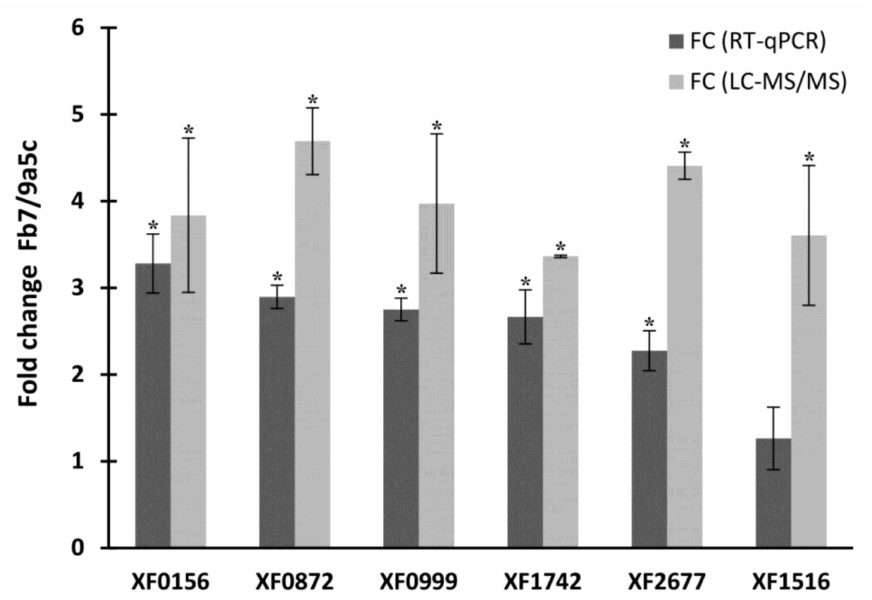
Figure 5. Expression ratios of selected genes comparing X. fastidiosa strains Fb7 and 9a5c, obtained by transcript (RT-qPCR) and protein abundance (LC-MS / MS). Results are expressed as mean ± SD and considered significant (*) if p < 0.001, Dunnett’s multiple comparison for RT-qPCR data